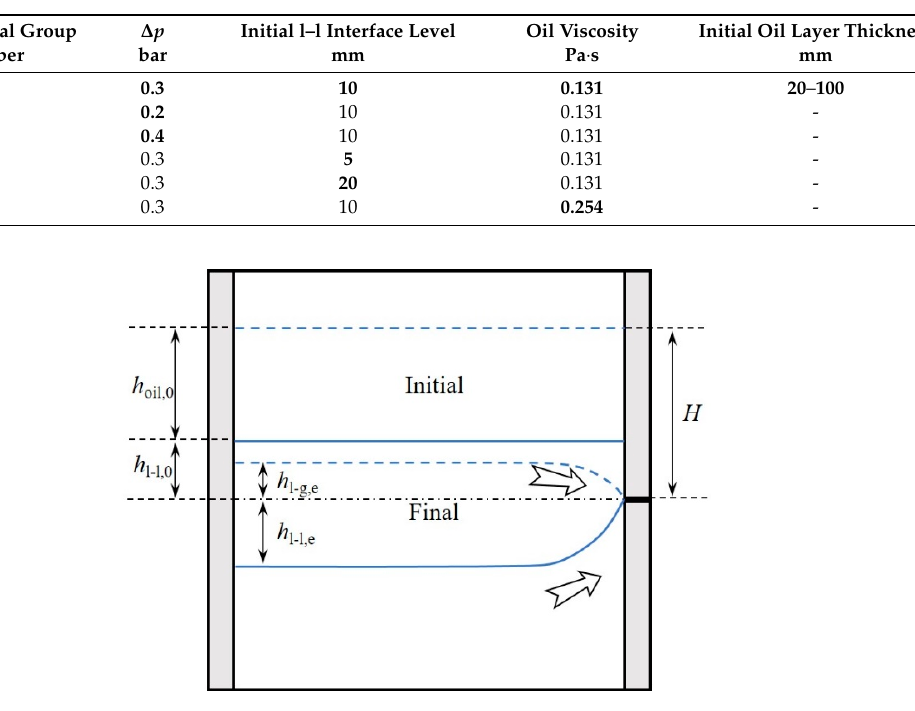
Figure 3. Schematic illustration of initial and final interface states. Solid lines: l–l interface, Dashed lines: l–g interface.